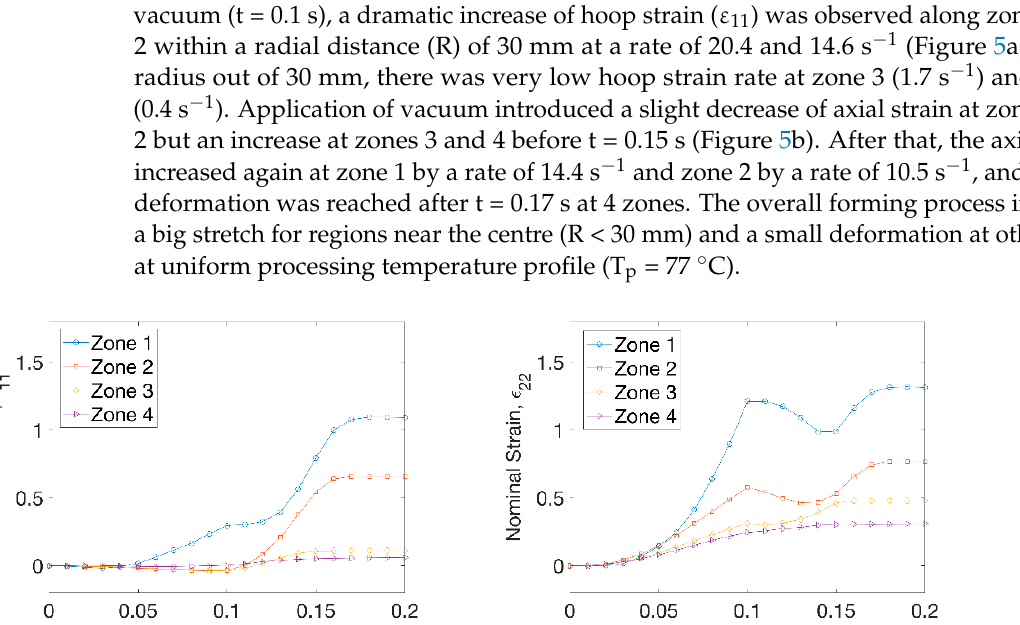
( b ) Figure 7. Optimal temperature values of each zone. ( a ) N = 4, ( b ) N = 6. By employing the optimal temperature (TEMP) profile at the two cases (N = 4 and 6), the spatial thickness (STH) distribution of formed sheet was compared with the result at the uniform temperature profile (T p = 77 °C) in Figure 8. It can be seen that non-uniform temperature distribution was presented after optimisation at a similar gradient at the two cases, which introduced the change of thickness profile. For both cases, high temperature of T p = 77 °C (red) covered the area near the edge of the sheet and there was a low-tem- perature region (T p = 72 °C) (blue) near the central region. The temperature between T p = 72 to 73 °C occupied the major transition part from low to high temperature at N = 4 (Fig- ure 8a). This region had a high-level temperature of T p = 73 to 75 °C at N = 6 (Figure 8b). Before optimisation, a thickness profile ranging from 0.4 to 1.6 mm along the whole sheet was found. By optimisation, the minimum thickness was improved to be over 0.61 mm.